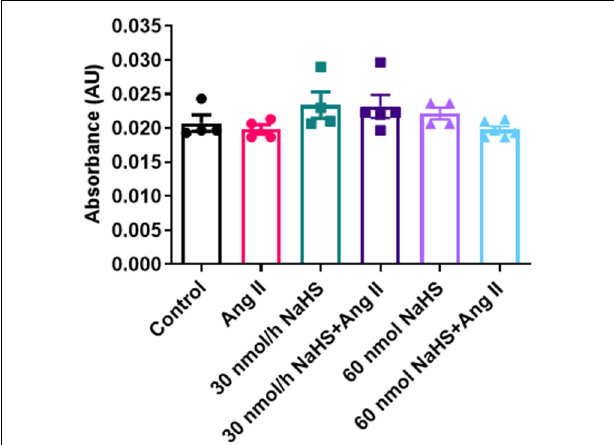
FIGURE 5 | Hydrogen sulfide levels in plasma of Sprague–Dawley rats with angiotensin (Ang) II hypertension and after intracerebroventricular NaHS administration as measured by methylene blue method. Data were analyzed by one-way ANOVA followed by Kruskal–Wallis test and presented as mean ± SEM. AU: arbitrary unit. Control ( n = 4), Ang II ( n = 5), NaHS ( n = 4), and NaHS/Ang II-treated rats ( n =